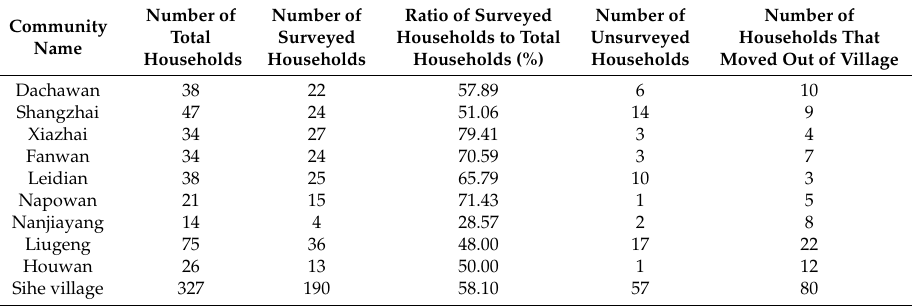
Table 1. Household survey of Sihe